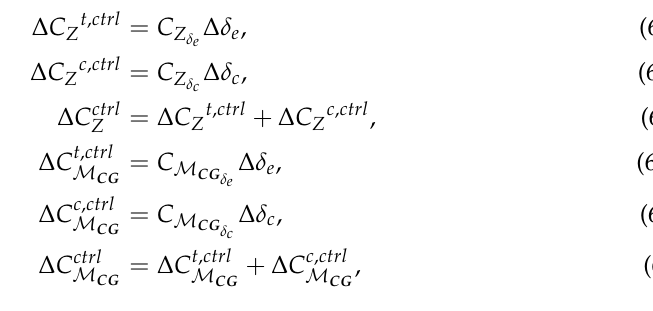
and δ c for response pilot pilot